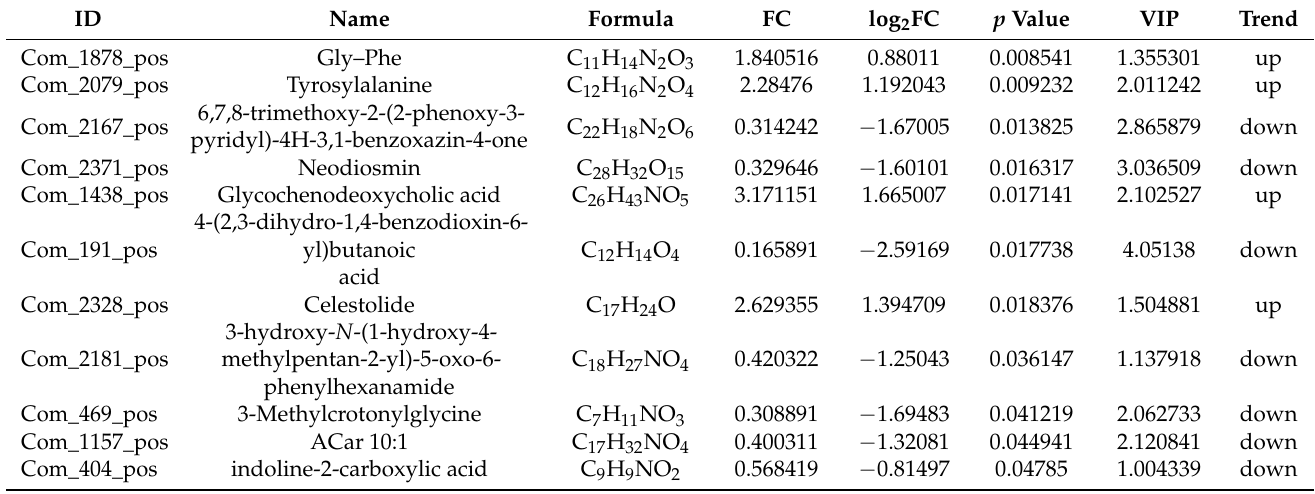
Figure 8. Differential metabolite volcano plots (( A ): positive mode; ( B ): negative mode). The abscissa represents the multiple changes in expression of metabolites in different groups (log 2 FC), and the ordinate represents the significant level of difference ( − log 10 p -value). Each dot on the volcano plot stands for a different metabolite; the red dot indicates a metabolite that has been significantly up-regulated, while the green dot indicates a metabolite that has been significantly down-regulated, and the size of the dot denotes the VIP value. Table 1. Significant difference metabolites in positive